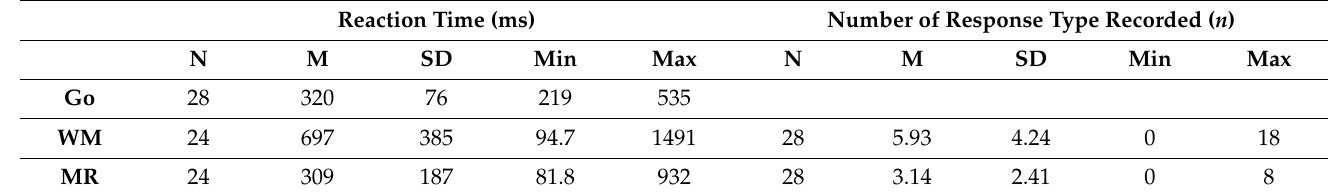
Table 5. Overall averaged RT for Go, “No Reach” (NR), “Wrist Movement” (WM) and “Miss-Reach” (MR) with different task type collapsed; the number of WM and MR responses recorded on average. Reaction Time